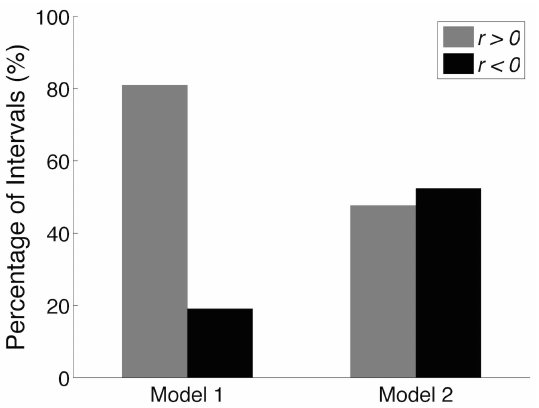
Figure 8. Correlation analysis between centre of mass (COM) displacement and Soleus (SO) muscle fibre length. Each bar represents the percentage of intervals (3-s duration windows) with positive (gray) and negative (black) correlation coefficients for each model structure. For Model 1 , * 80% of intervals (17/21) had positive correlation coefficients, while for Model 2 this proportion was lower than 50% (10/21). Statistically significant difference was observed between the results from the two model structures ( Model 1 vs. Model 2 , x 2 -test, p v 0 : 05 ). These results suggest that reciprocal inhibition may contribute significantly to the ‘‘paradoxical’’ behaviour (negative correlation between COM and muscle fibre length) reported in the literature